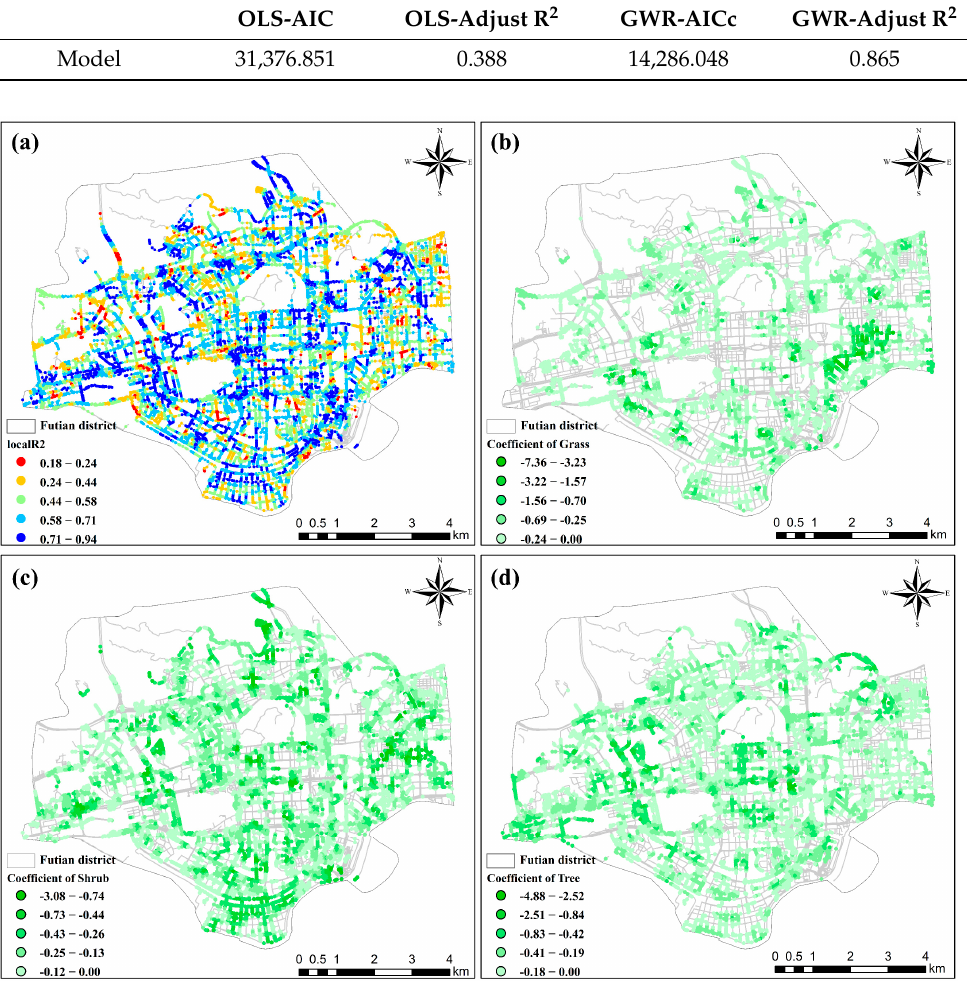
Figure 7. GWR model results: ( a ) local R 2 values of GWR, ( b ) grass ratio coefficients, ( c ) shrub ratio coefficients and ( d ) tree ratio coefficients.